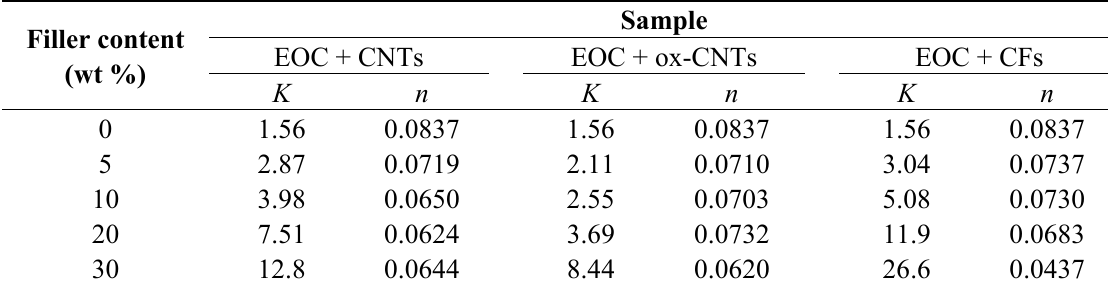
Table 2. Power law fluid factors K and n , obtained by fitting the experimental Young’s modulus from the tensile tests (Figure 5) with Equation (5).